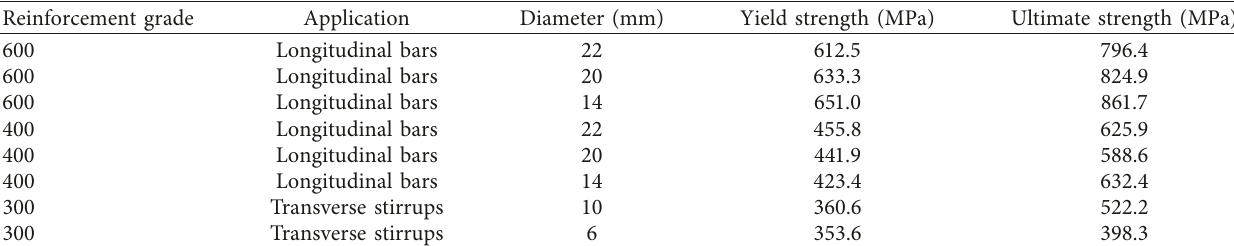
Figure 1: Details of test specimens. (a) Sizes and reinforcement of beam and column and (b) reinforcement details of joint region. Table 2: Material parameters of